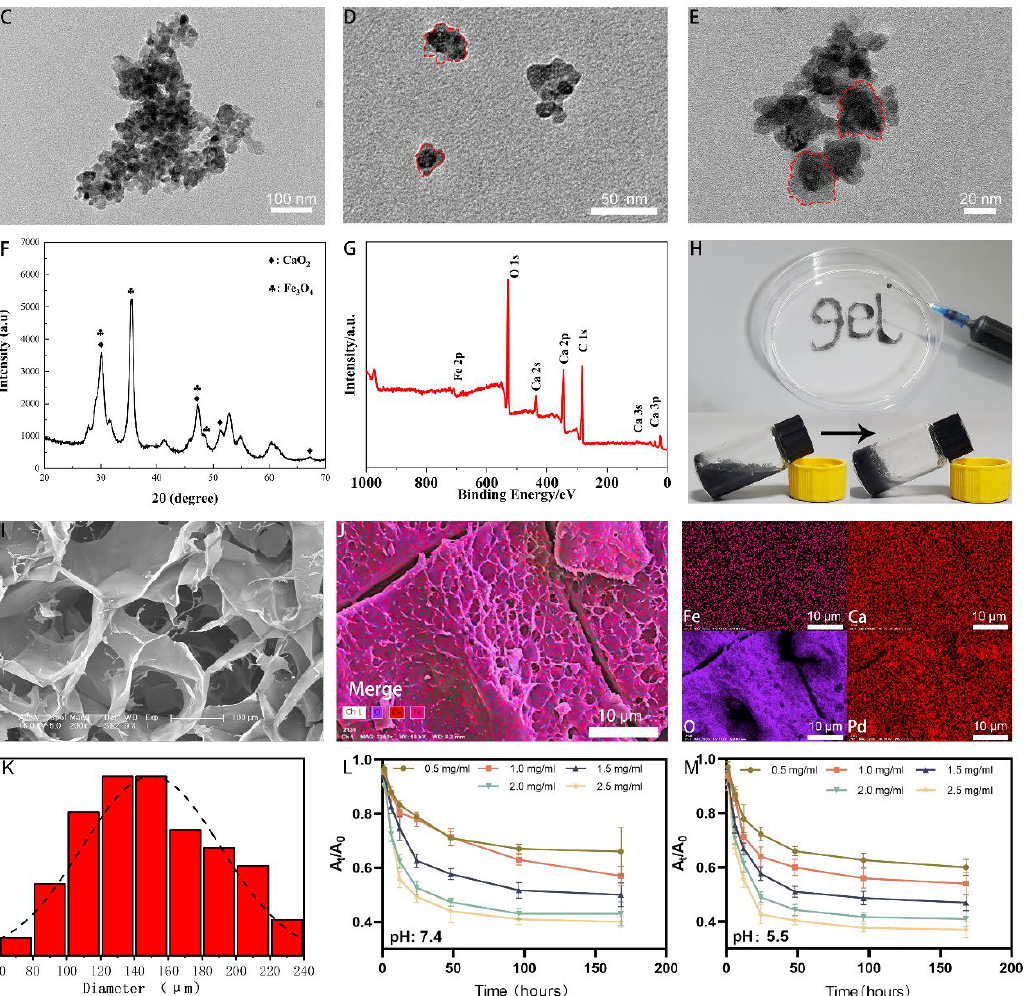
Figure 1. Characterization of Fe 3 O 4 -CaO 2 NPs and Fe 3 O 4 -CaO 2 -Hydrogels. ( A ) Schematic illus- tration of the preparation of Fe 3 O 4 -CaO 2 NPs. ( B ) Schematic illustration of the preparation of Fe 3 O 4 -CaO 2 -Hydrogel. ( C – E ) Representative TEM images of the prepared Fe 3 O 4 -CaO 2 NPs, Red circles represent Individual Fe 3 O 4 -CaO 2 NPs. ( F ) XRD, ( G ) XPS analysis of the prepared Fe 3 O 4 -CaO 2 NPs. ( H ) Demonstration of injectable property of Fe 3 O 4 -CaO 2 -Hydrogel, Inset: Gelling process of Fe 3 O 4 -CaO 2 -Hydrogel. ( I ) SEM image of the Fe 3 O 4 -CaO 2 -Hydrogel. ( J ) Elemental mappings of Fe, Ca, O, and Pd of Fe 3 O 4 -CaO 2 -Hydrogel. ( K ) Pore size distribution of the Fe 3 O 4 -CaO 2 -Hydrogel. ( L , M ) The release of ROS by different dosages of Fe 3 O 4 -CaO 2 NPs embedded in hydrogels under different pH